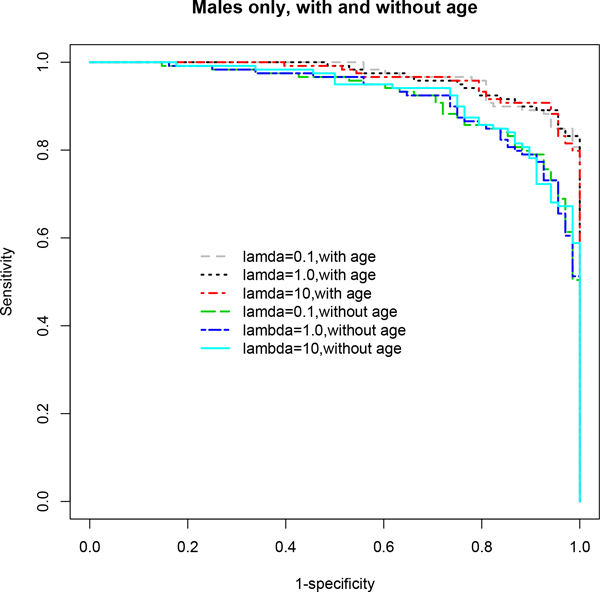
ROC curves based on multivariable stepwise penalized logistic regression models (stepPLR) using the stratified male-only subset. The age-adjusted final model for λ = 0.1 showed the best performance in terms of AUC. A clear distinction is seen in the ROC curves for age-adjusted models compared to age-unadjusted models. Age-adjusted models demonstrated superior performance overall across all choices of λ. See Table 1 for detailed results and the text for discussion of these results.